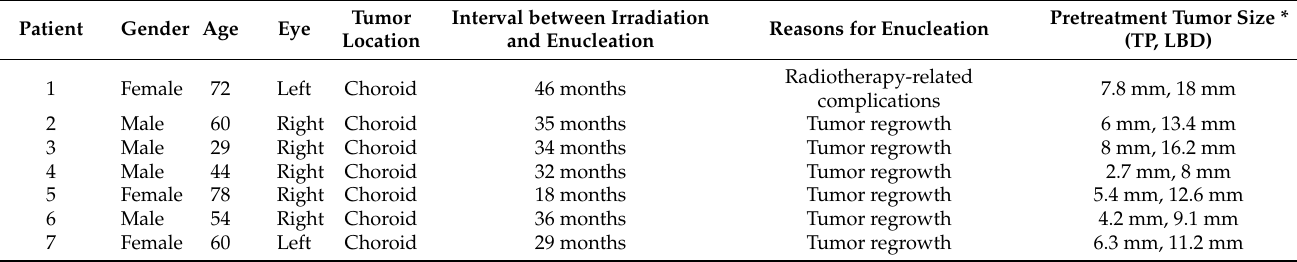
Table 2. Demographic and clinicopathological characteristics of the irradiated